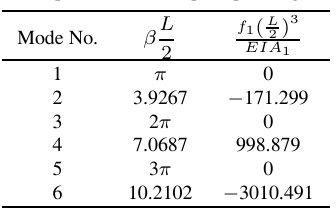
Natural frequencies and support reactions for six-span beam. β 4 = ρAω